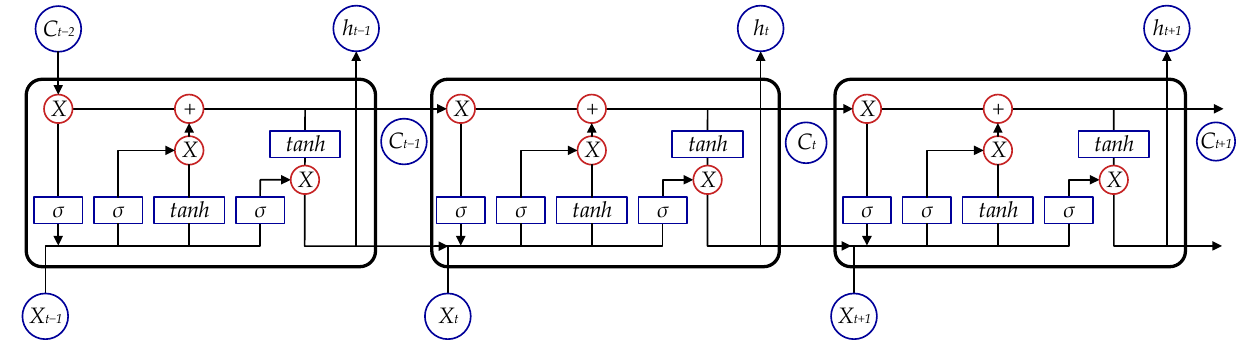
Figure 4. LSTM architecture schematic.